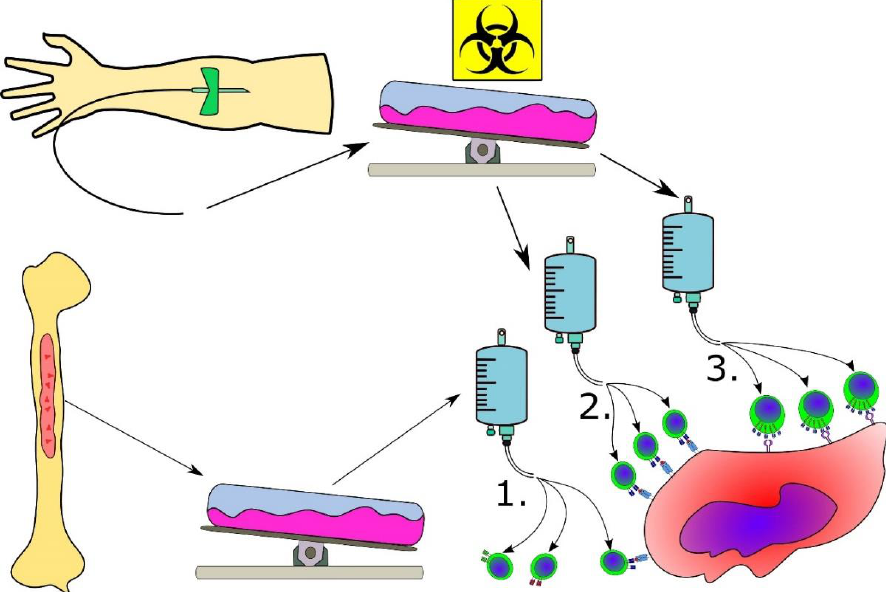
Figure 4. Cytotherapeutic modalities for MPN. ( 1 ). Tumor-infiltrating lymphocytes (TIL) are